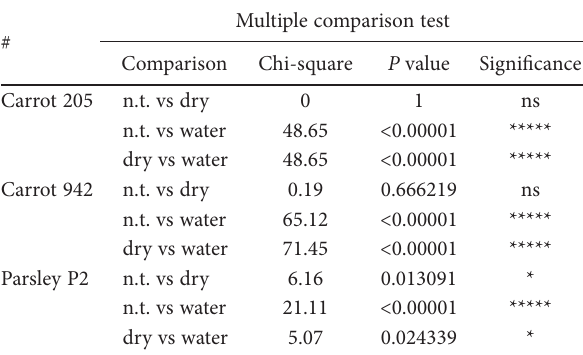
Table 1b. Post-hoc multiple comparison test results following Chi- square test with more than two treatments, when significant differ- ence among groups was indicated in the first test (Table